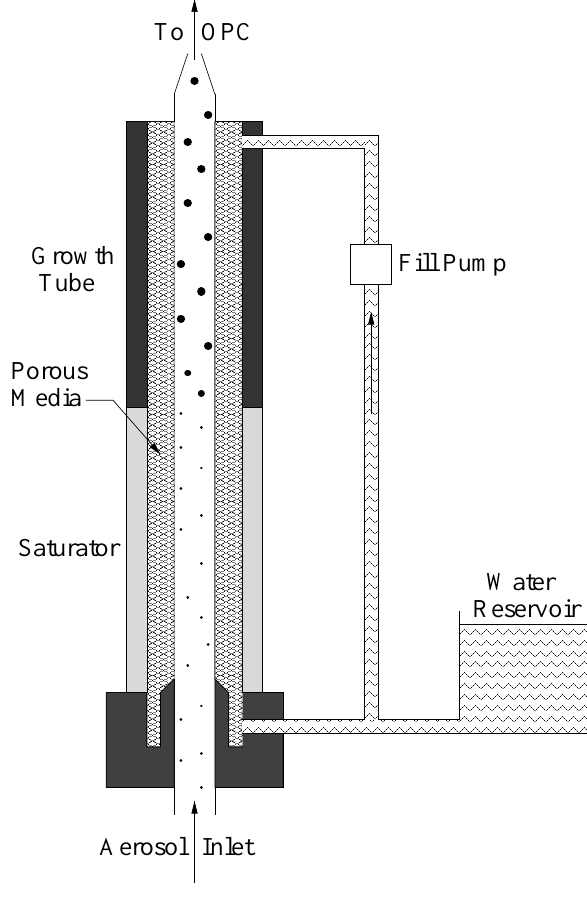
Fig. 1. A schematic diagram of a TSI 3785